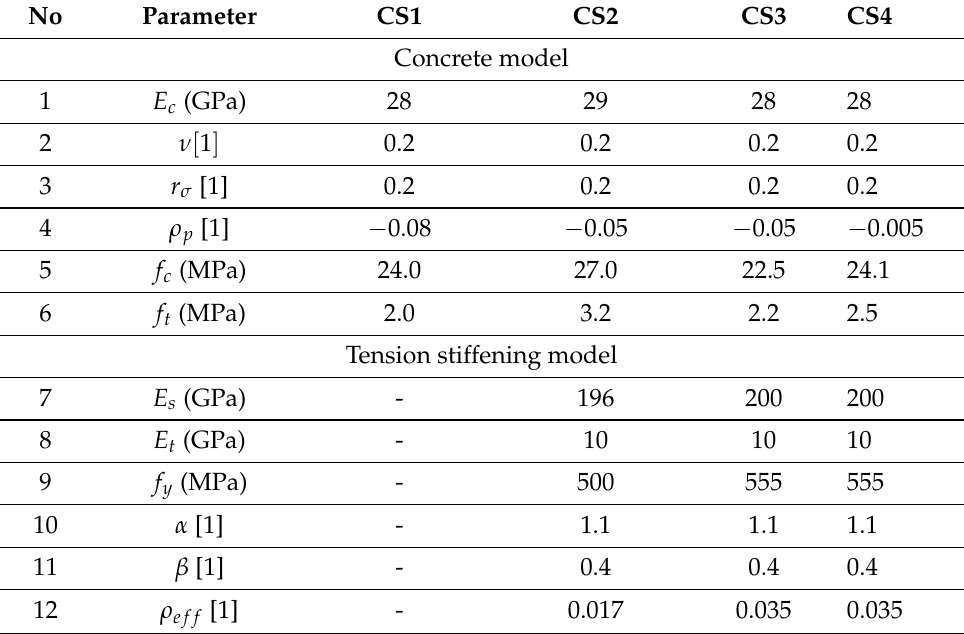
Table 1. Parameters of proposed models adopted in case studies.